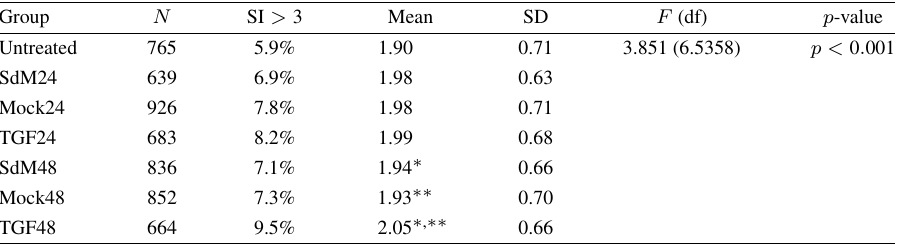
Mean Spindle Index increased 48 h after treatment with TGF- β